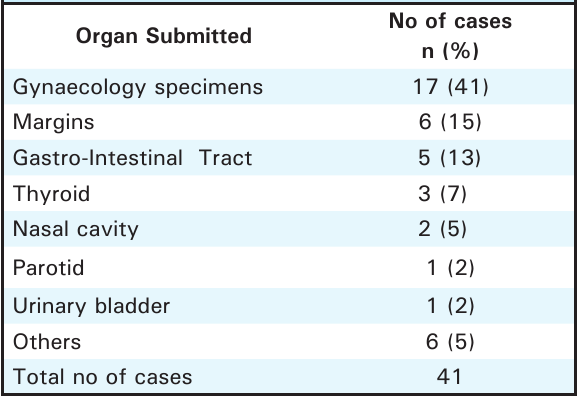
Table 1. Organs submitted for frozen